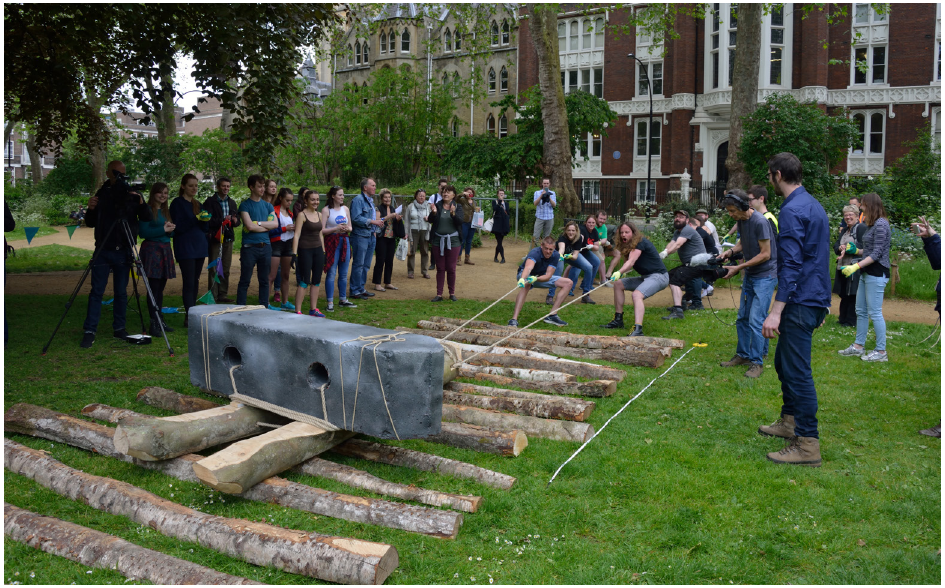
Figure 4: The stone dragging experiment in Gordon Square garden (Photo Adam Stanford/